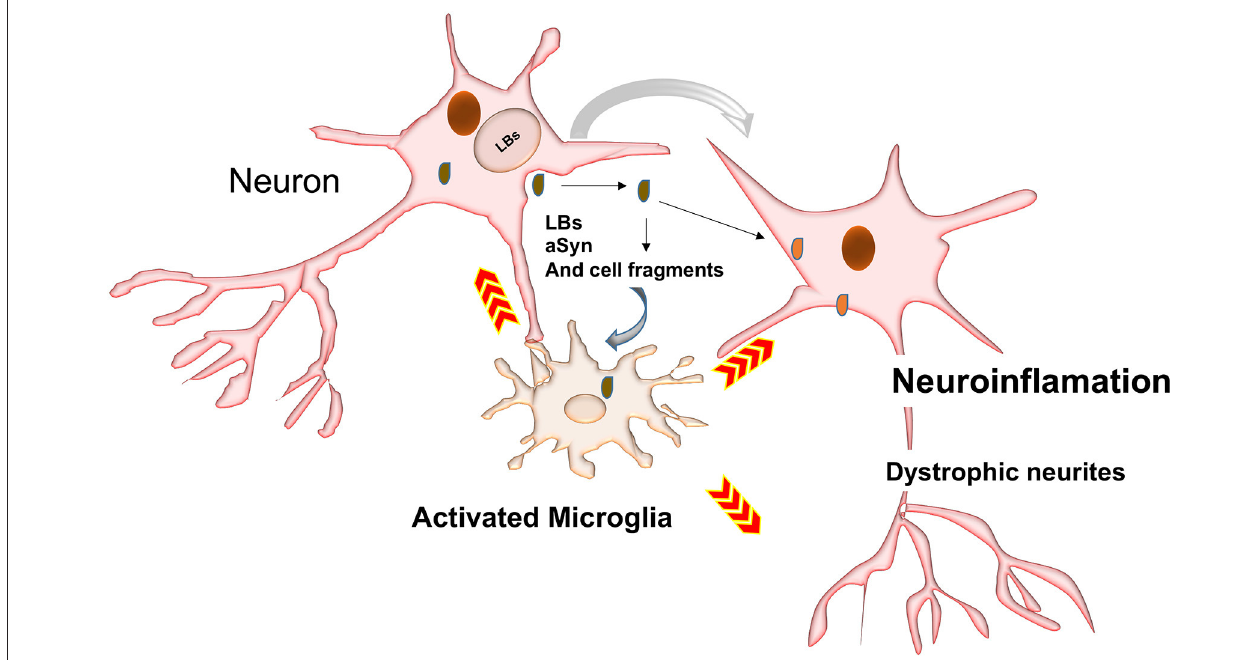
FIGURE 4 | Possible mechanisms involved in activation of phagocytosis and inflammatory responses. LBs may be passively secreted in the extracellular environment following cell death by cell-to-cell transfer. Inclusions and their toxic intermediates may activate astrocytes and glia cells surrounding neurons, resulting in the release of pro-inflammatory cytokines and ROS, which could damage neighboring neurons.